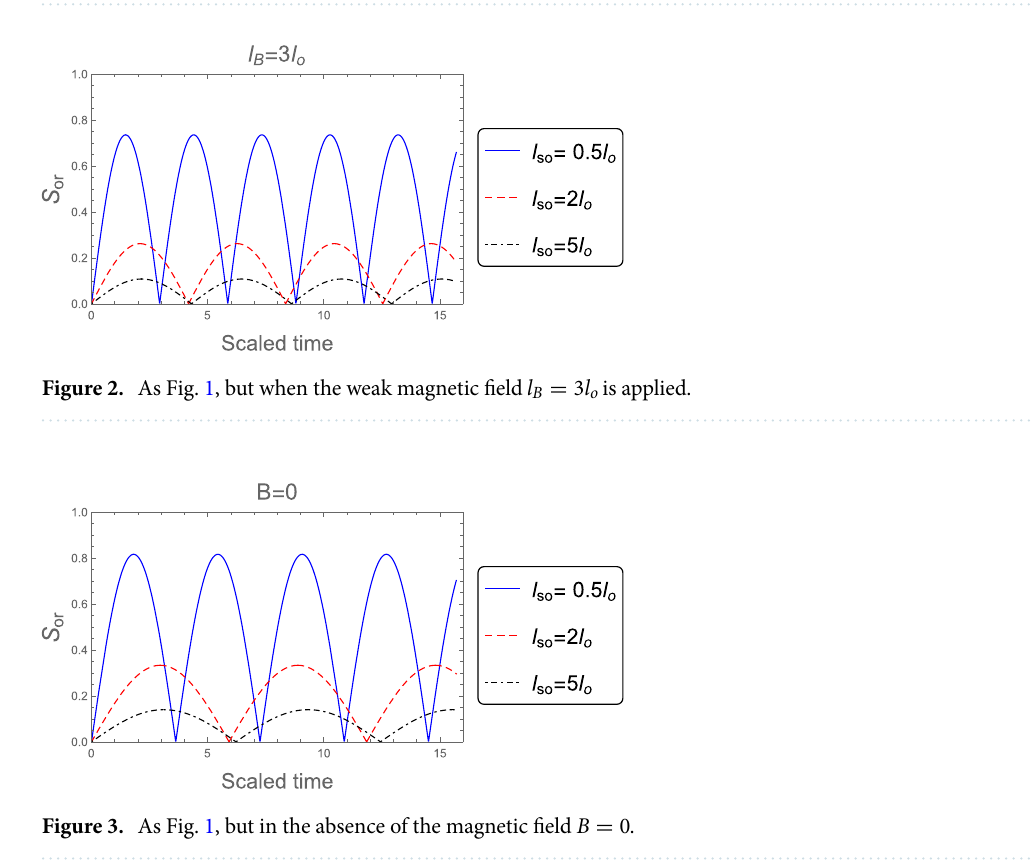
Figure 3. As Fig. 1, but in the absence of the magnetic field B